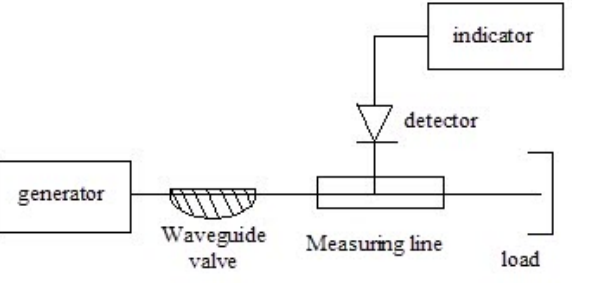
Figure 12. Scheme of the setup for the study of dielectrics in the microwave range using a measuring line. Adapted from [129] with permission.